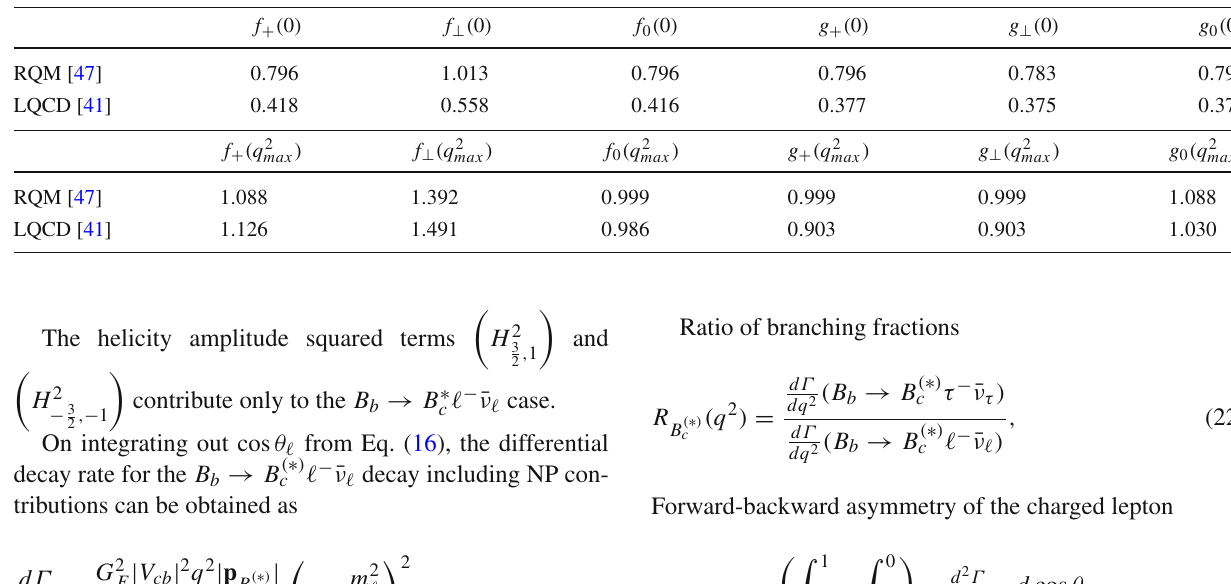
Table 1 Form factors predictions for Λ b → Λ c at q 2 = 0 and q 2 = q 2